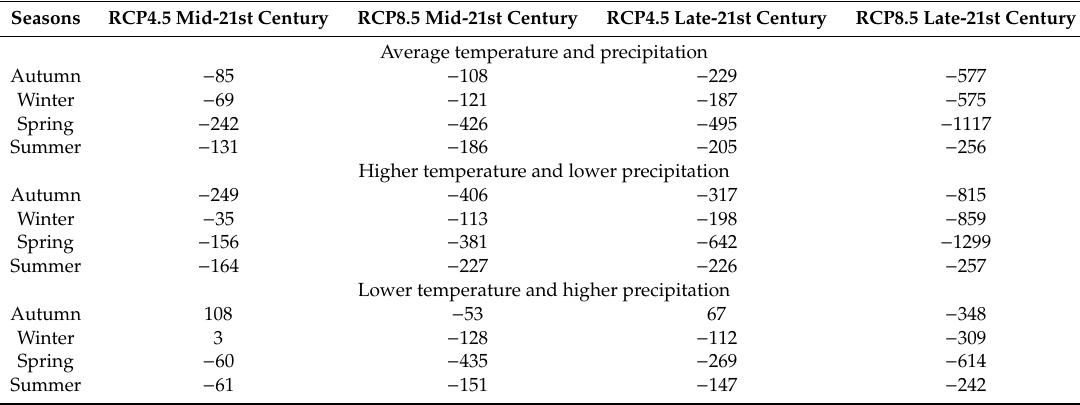
Figure 7. Projected SCA during the late 21st century (2089–2095) under ( a ) RCP4.5 and ( b ) RCP8.5, for average, lower, and higher temperature and precipitation scenarios. Table 5. Projected seasonal SCA in (km 2 ) during the mid- and late 21st century under RCP4.5 and RCP8.5, for average, lower, and higher temperature and precipitation